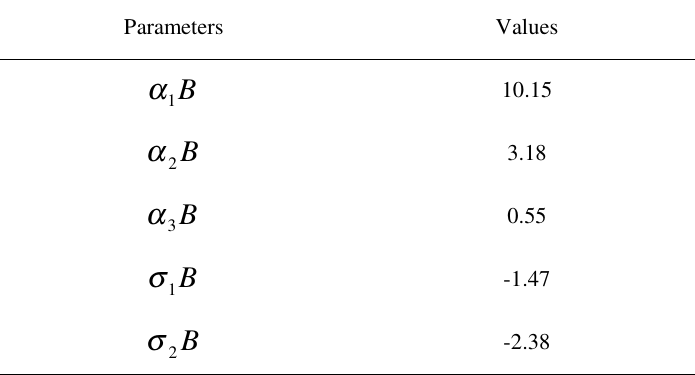
Table 1 Values of second-order potential parameters (in G Pa) of Calcite.